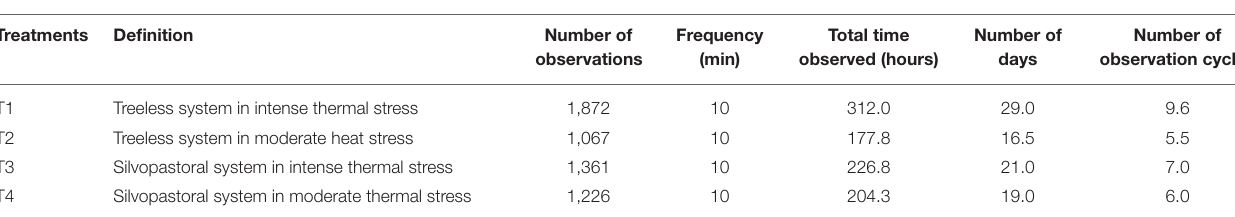
TABLE 1 | Outline of experimental